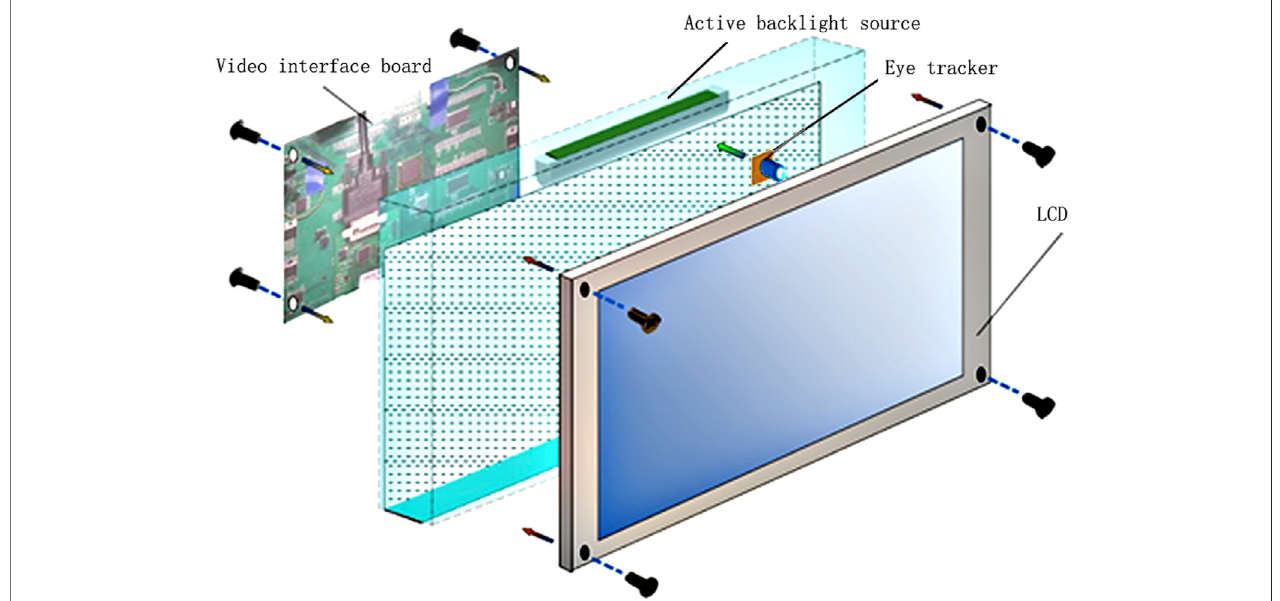
FIGURE 1 | A schematic illustration of the autostereoscopic display system with the eye tracker in the GFDRDSS.